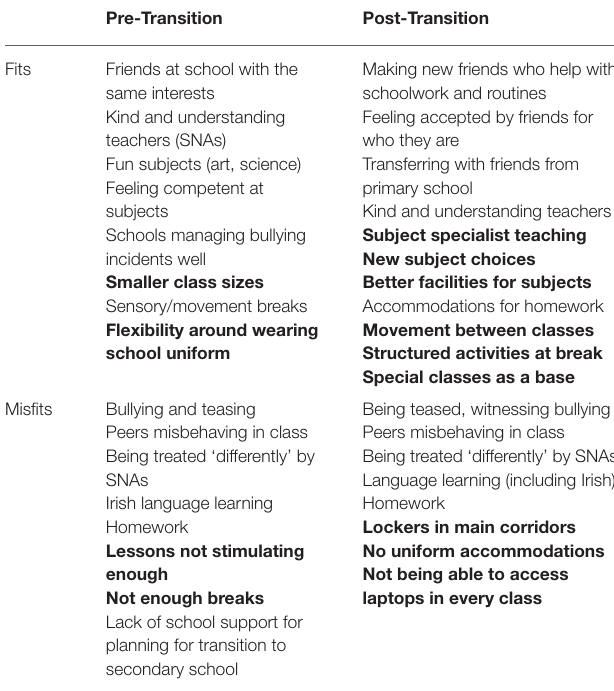
TABLE 6 | Fits and misfits across transition (discontinuities in bold).